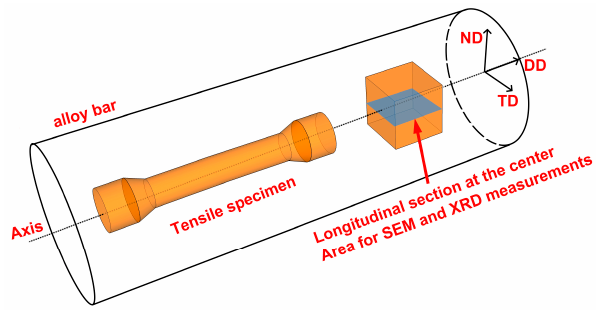
Figure 1. A schematic diagram of sampling location in VT3-1 alloy bars. The DD, ND and TD represent the drawing direction, normal direction and transverse direction, respectively. SEM: scanning electron microscopy; XRD: X-ray diffraction.